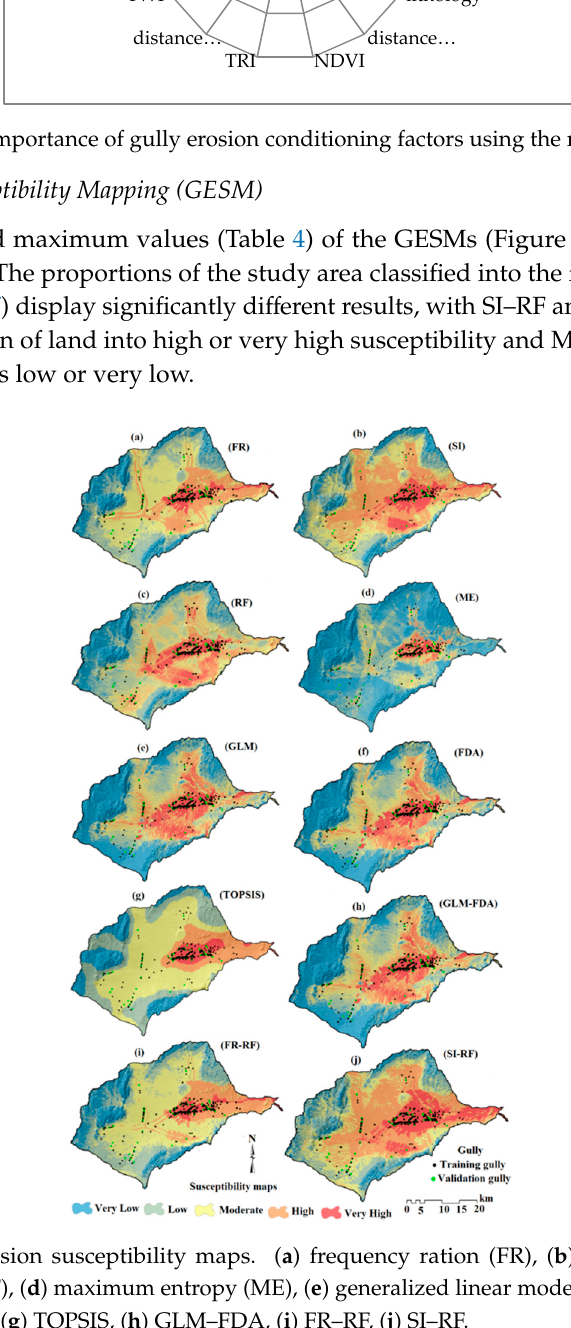
Table 4. Values of resulted gully erosion maps using ten models.